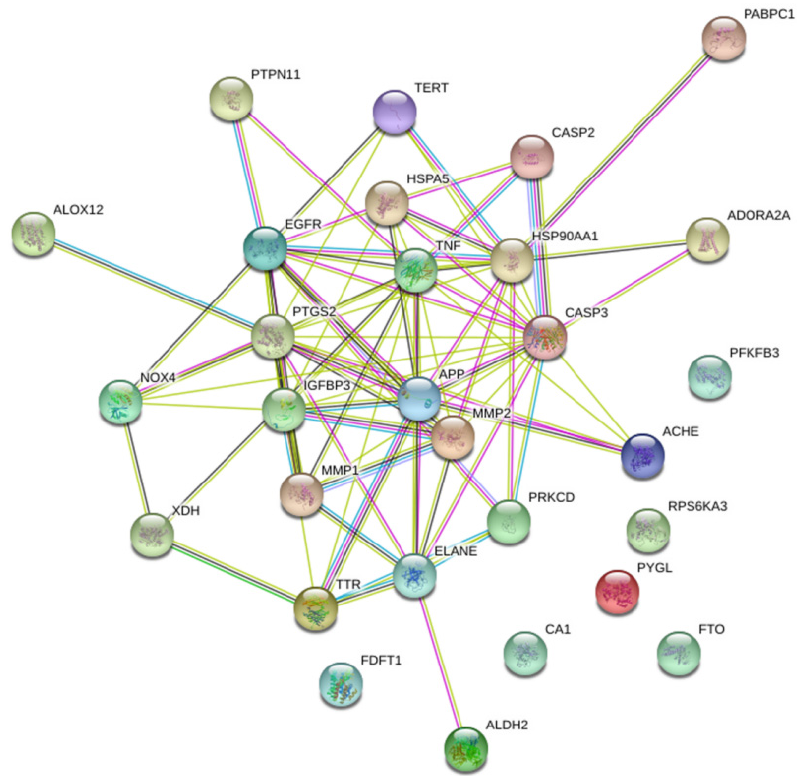
Figure 2. PPI Network for potential targets of LJF against NAFLD. Network nodes represent proteins; edges represent protein–protein associations, blue edges represent known interactions from curated databases, purple edges represent known interactions experimentally determined, yellow edges represent interactions from text mining.